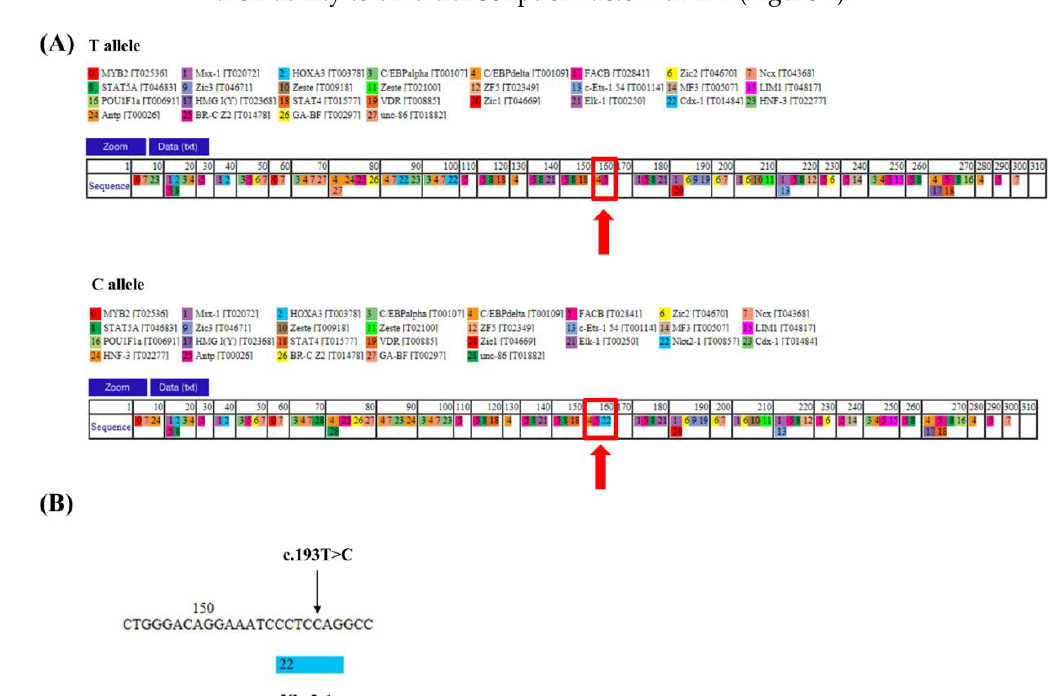
Figure 2. Analysis of the transcription factor-binding abilities of 2 haplotypes of the proximal promoter sequence of the bovine IFITM3 gene. ( A ) The transcription factor-binding site according to c.-193T > C allele. Red boxes and arrows indicate differences in the transcription-binding sites of the haplotype of -193T > C with the T allele and the haplotype of -193T > C with the C allele. ( B ) Magnified view of the locus containing c.-193T > C region showing differences in Nkx2-1 binding between the haplotype with the T allele of -193T > C and the haplotype with the C allele of -193T >